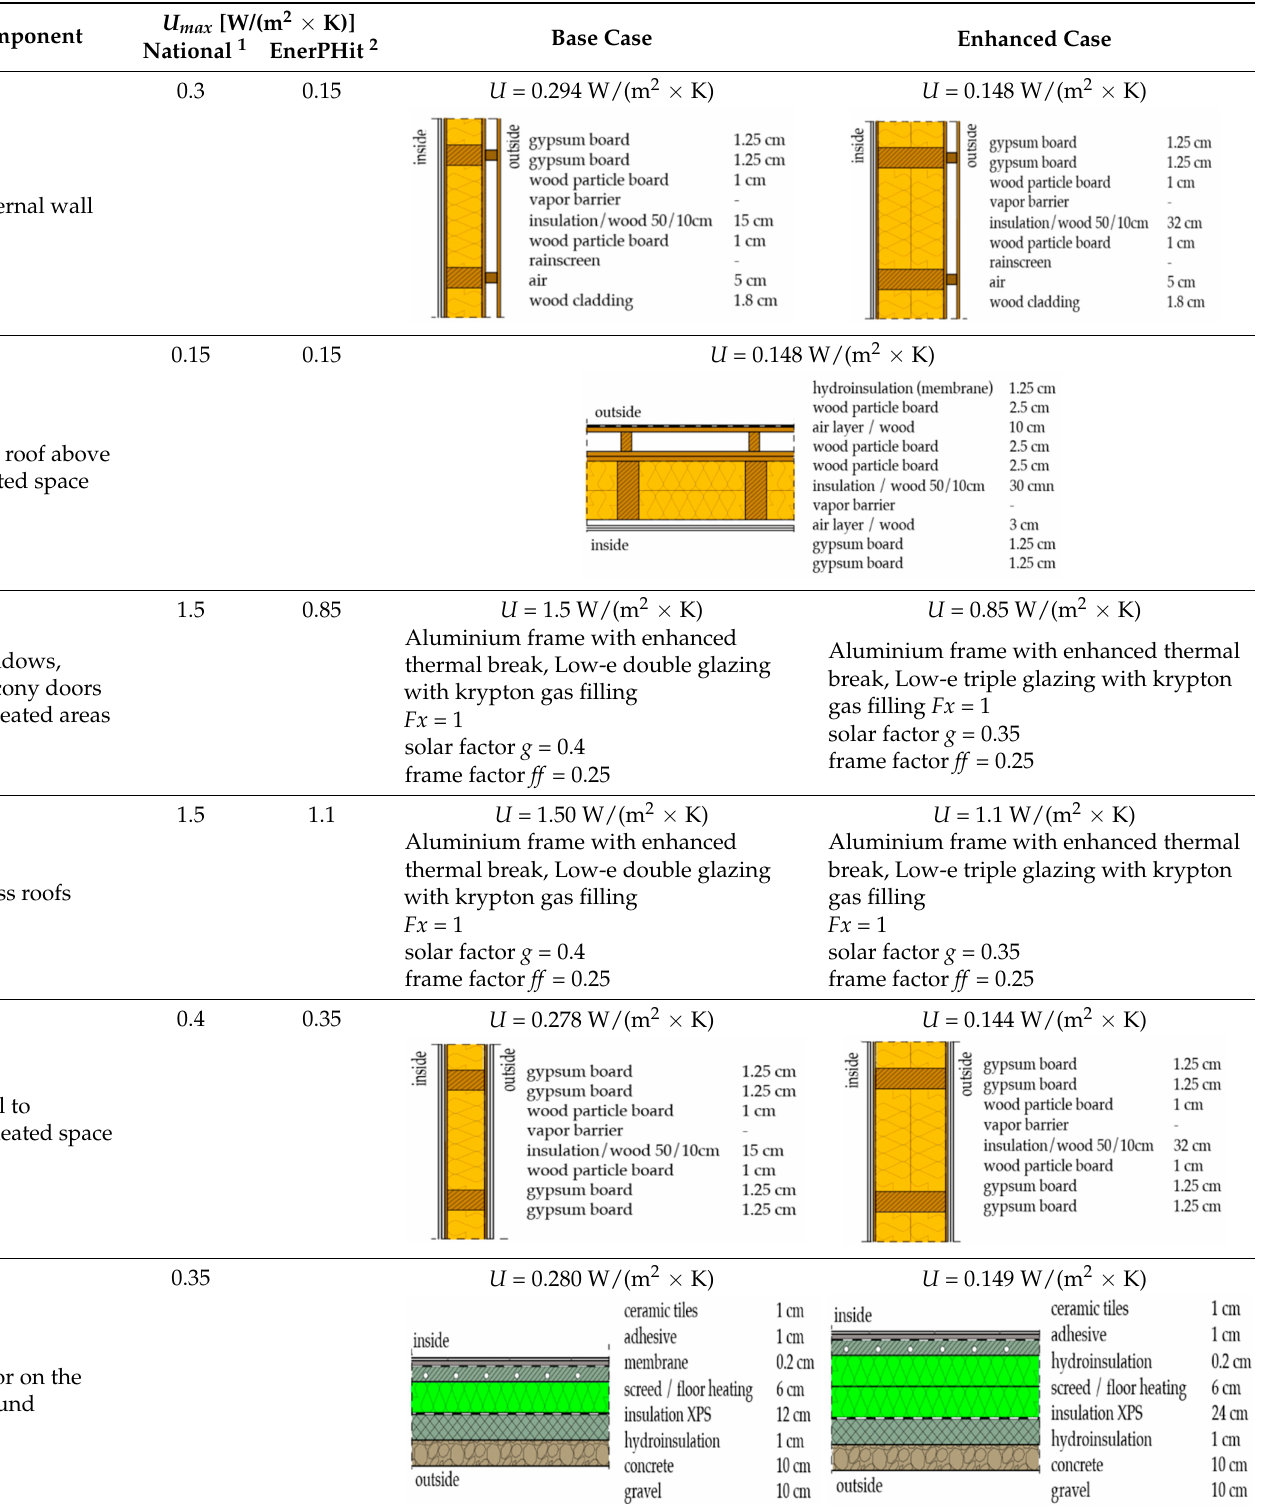
Table 3. Thermal envelope